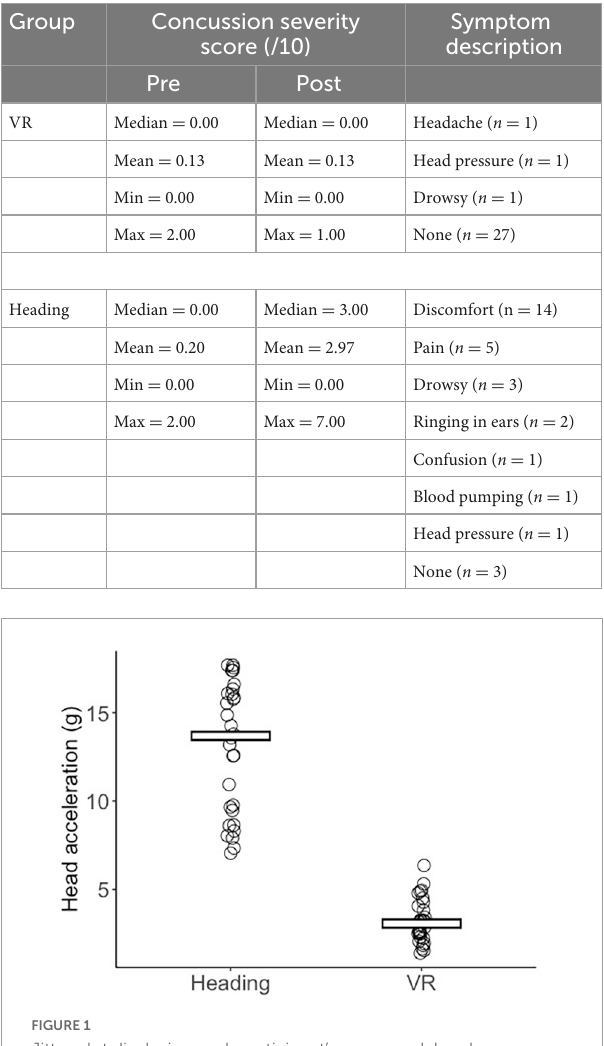
TABLE 1 Self-report data on the severity and description of concussion symptoms pre and post-test for each experimental condition.